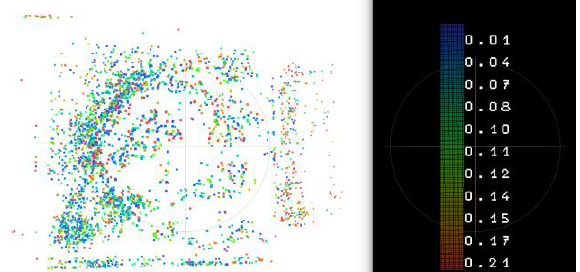
Figure 7. 3D model representing the residuals of the tie-points relative to the calibration and relative orientation performed using the Fraser’s model.